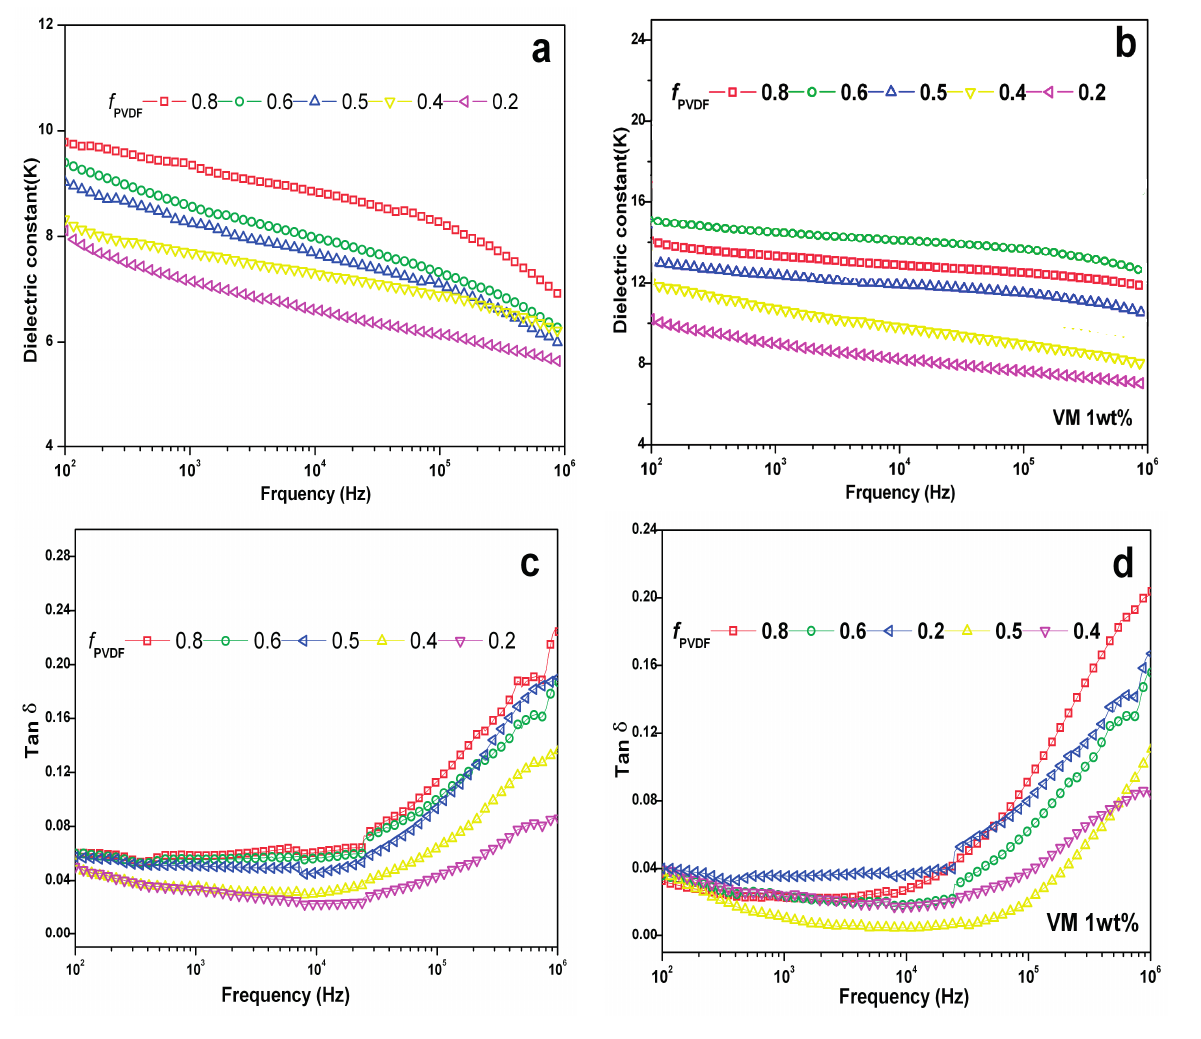
Figure 1. Frequency dependence of dielectric constant for polyamide/polyvinylidene fluoride (PA11/PVDF) blends: ( a ) without VA-MA; and, ( b ) with VA-MA added. Frequency dependence of dielectric loss, tan δ , for PA11/PVDF blends: ( c ) without VA-MA; and, ( d ) with VA-MA